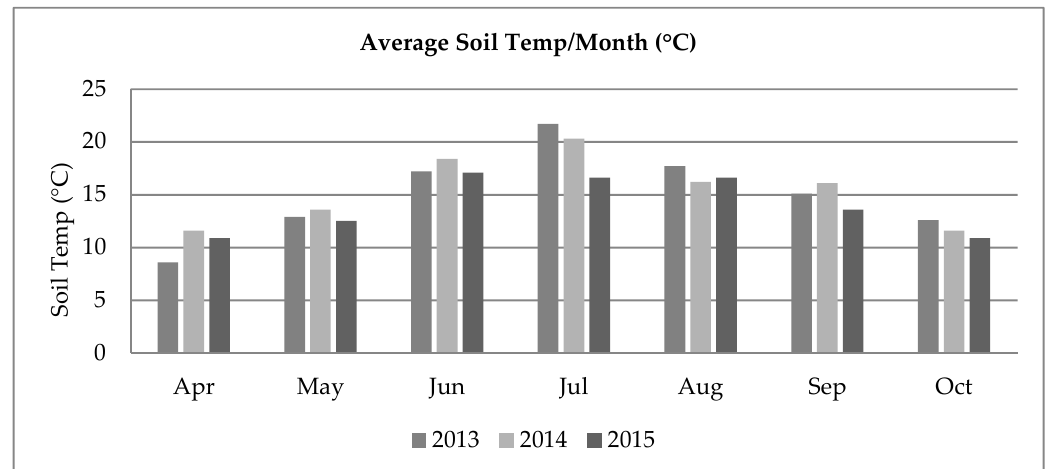
Figure 3. Average soil temperatures per month for the three trial years from April to October.